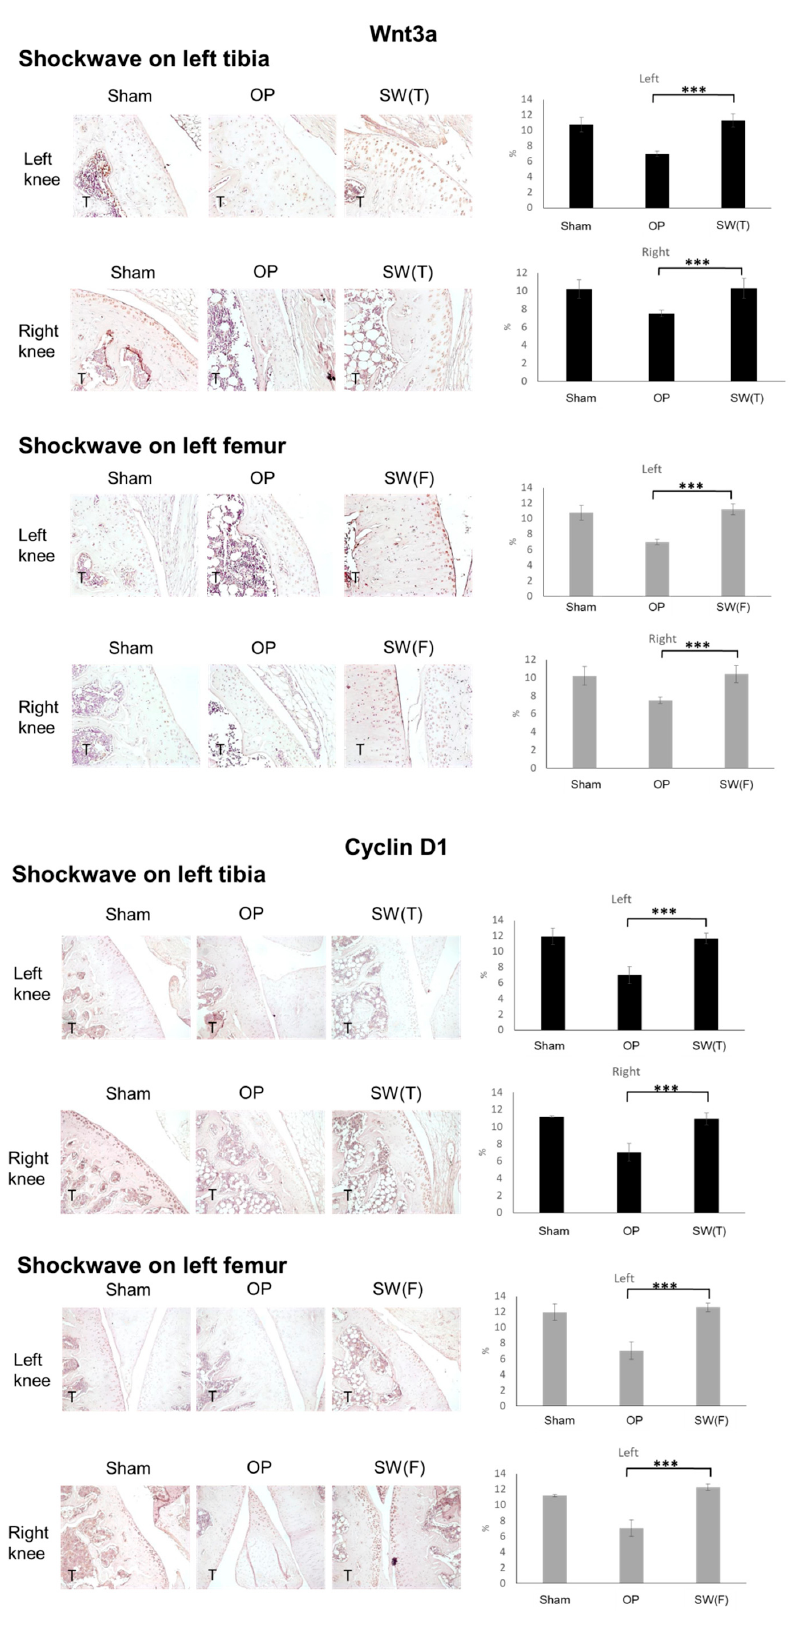
Figure 5. Long-range e ff ects of shockwave therapy on the expressions of Wnt3a and Cyclin D1 in the articular cartilage ( × 100 magnification) of the tibia of the right and left knees in the Sham, OP, SW(T), and SW(F) groups. T = tibia. N = 6. *** p < 0.001. Values are the mean ±